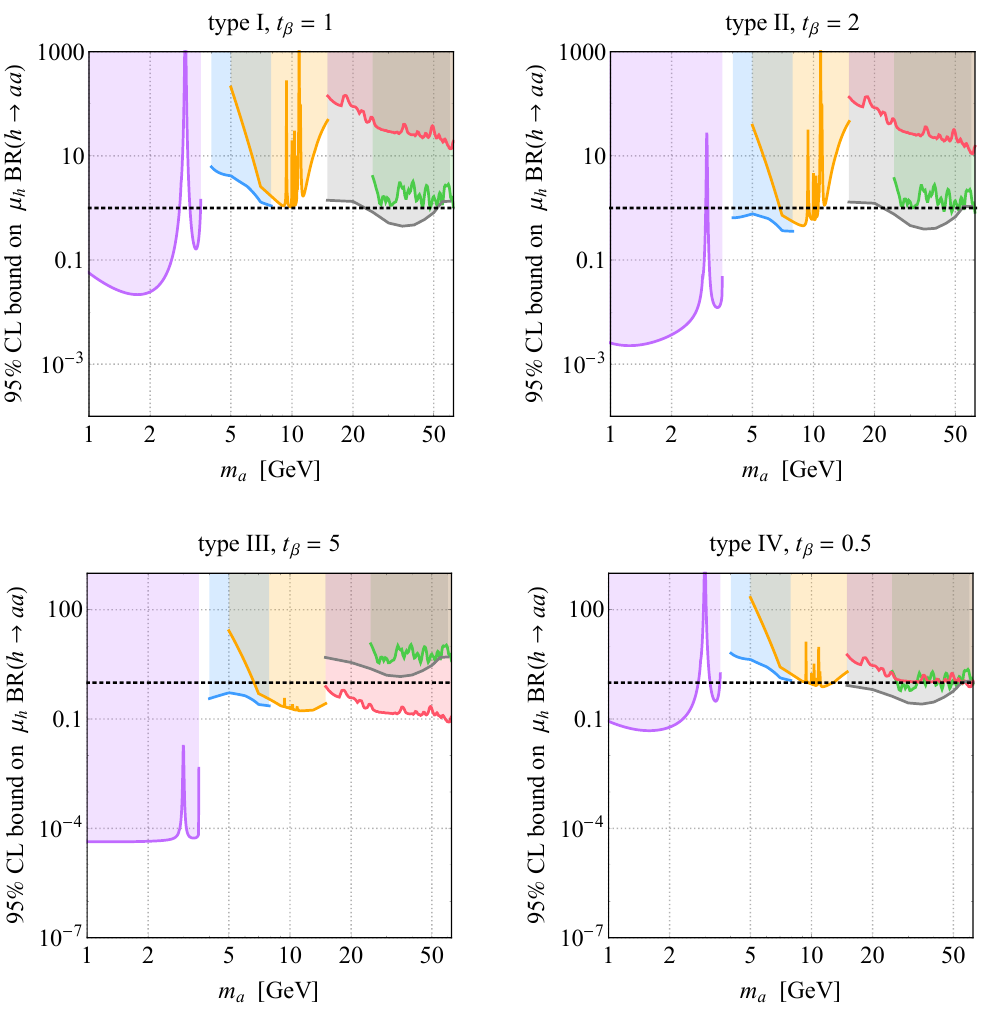
Figure 1 . Limits on (cid:22) h BR( h ! aa ) in the 2HDM+S of type I with t (cid:12) = 1 (top left), type II with t (cid:12) = 2 (top right), type III with t (cid:12) = 5 (bottom left) and type IV with t (cid:12) = 0 : 5 (bottom right). The purple, blue, orange, red, green and gray exclusions correspond to the search for h ! aa ! 4 (cid:22) [17], h ! aa ! 4 (cid:28) [19], h ! aa ! 4 (cid:28) [20], h ! aa ! 2 (cid:22) 2 (cid:28) [20], h ! aa ! 2 (cid:22) 2 b [20] and h ! aa ! 2 (cid:28) 2 b [21], respectively. The dashed black lines indicate (cid:22) h BR( h ! aa ) = 1 and all coloured regions are excluded at 95%